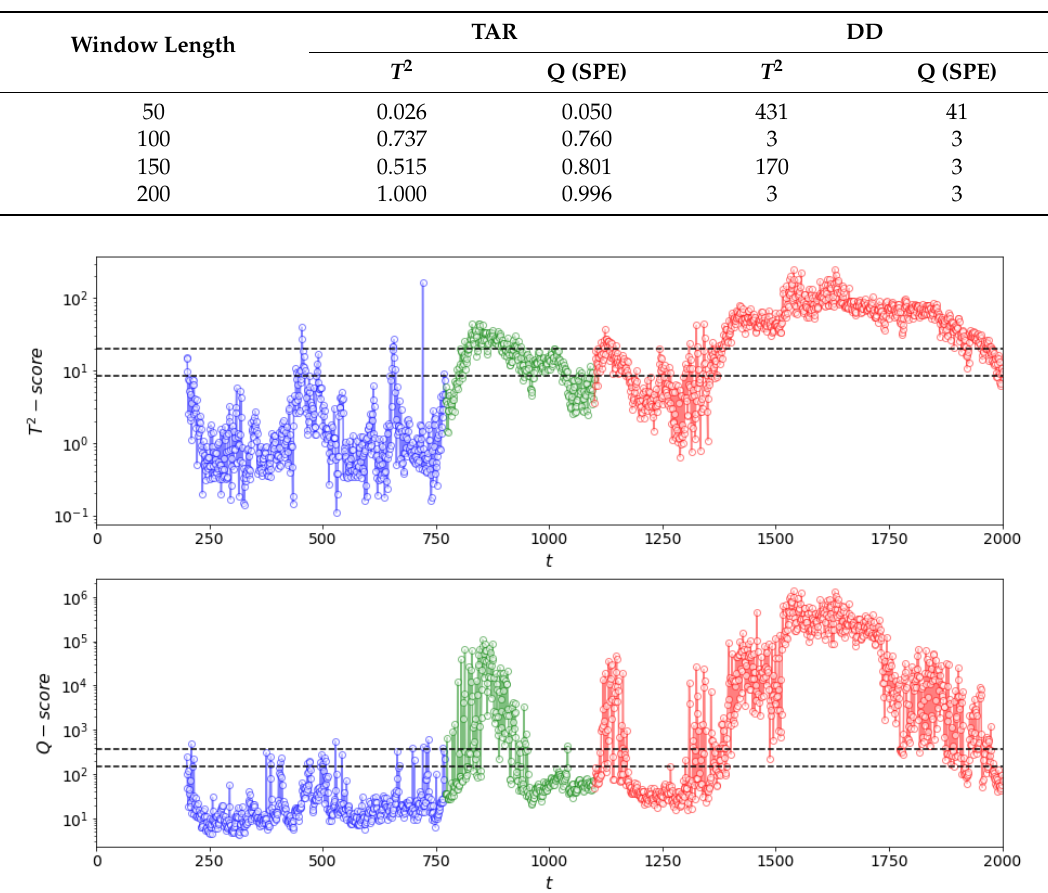
Figure 20. T 2 ( top ) and Q ( bottom ) process monitoring charts of AG mill power draw for a window length of 200 time steps using Method II. Training non-fault data are shown in blue, untrained non-fault data in green and test (fault) data in red.